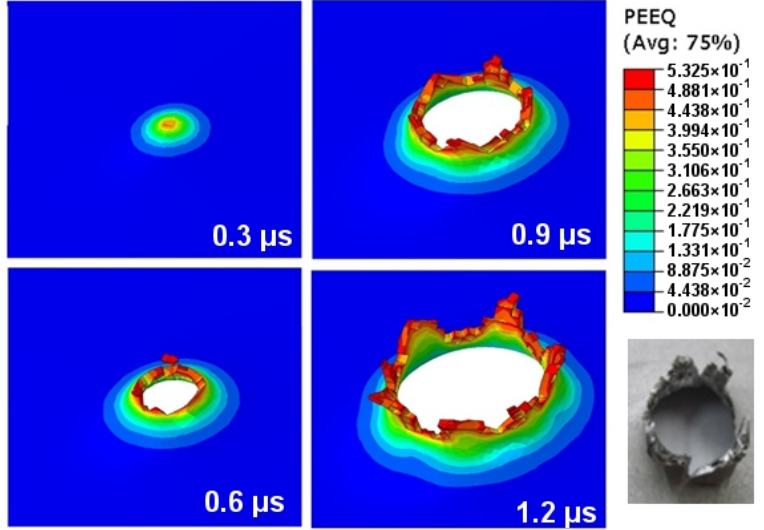
Figure 19. PEEQ strain visualization during the puncture of a sheet made of titanium alloy.